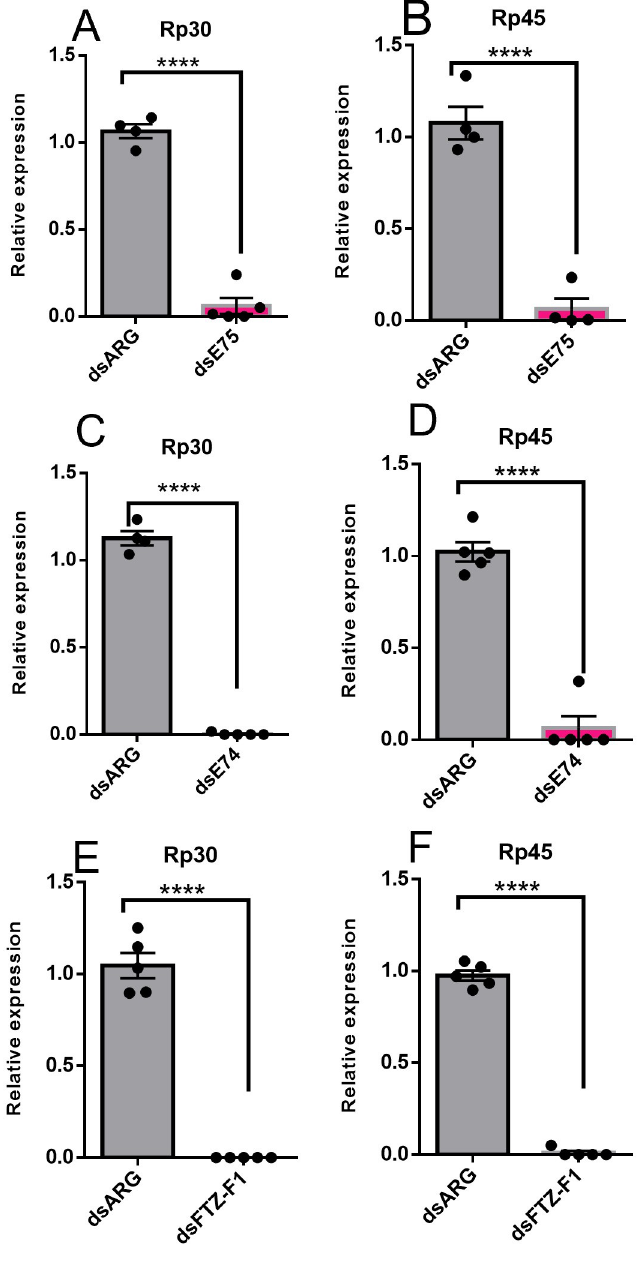
Fig 11. The effect of RNAi-mediated knockdown of E75 , E74 or FTZ-F1 transcripts on expression of transcripts involved in choriogenesis ( Rp30 and Rp45 ) in the ovary 4 days post blood meal (PBM). Relative transcript levels of Rp30 and Rp45 were measured using RT-qPCR and analyzed using the 2 − ΔΔ Ct method. The results are shown as mean ± SEM (n = 4–5). Rp49 and β -actin were used as reference genes. Statistical analysis was performed using Student’s t-test. ���� p < 0.0001. mRNA of EcR and USP are decreased by 80–90% in B . mori E93 RNAi larvae compared to their control counterparts [71]. Furthermore, in B . mori E75 RNAi disrupts the 20E-triggered transcriptional cascade by lowering EcR-B1 and USP protein levels [72] and in D .